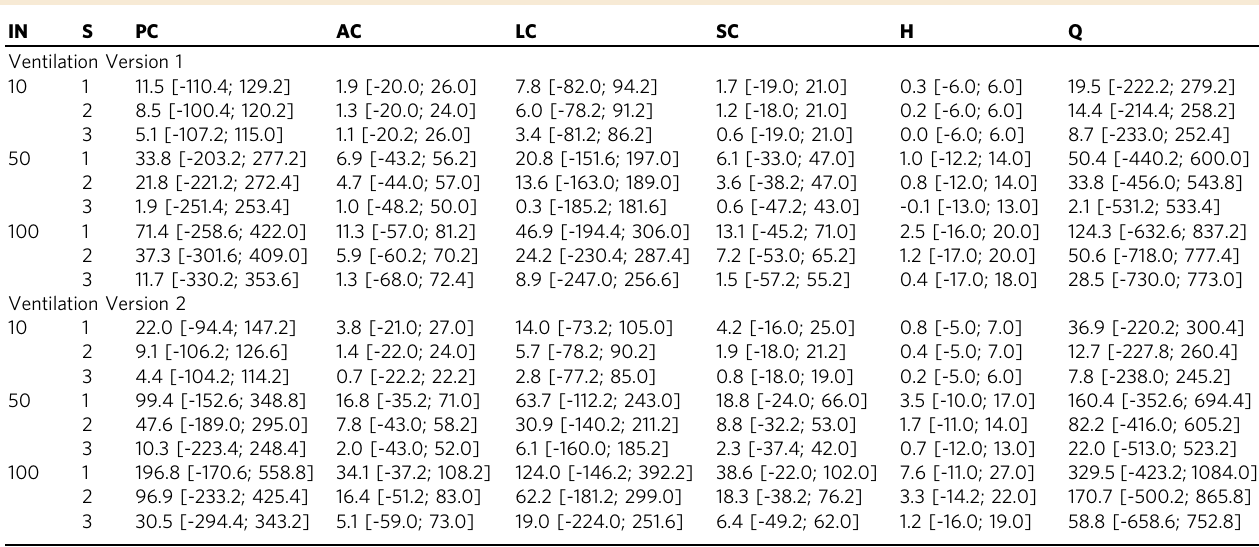
Table 2 Simulated mean excess numbers caused by mass gathering events (MGE). IN